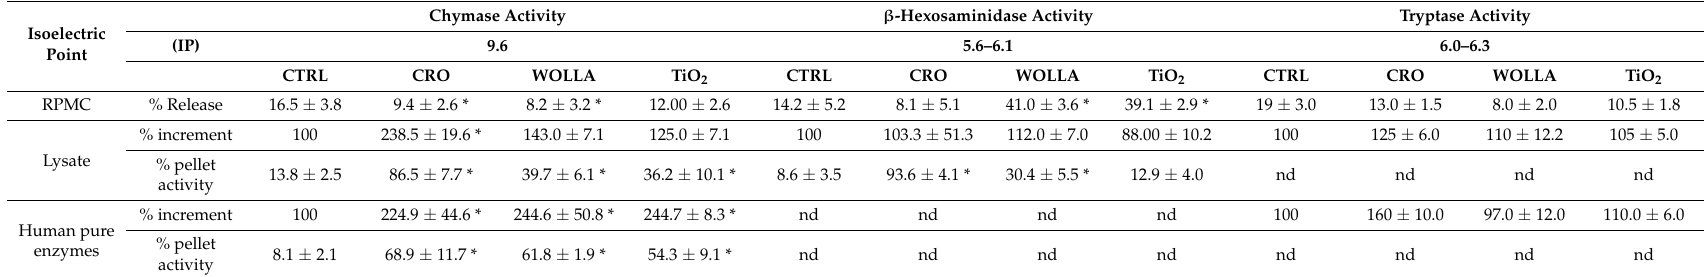
Table 1. Summary of fiber–enzyme